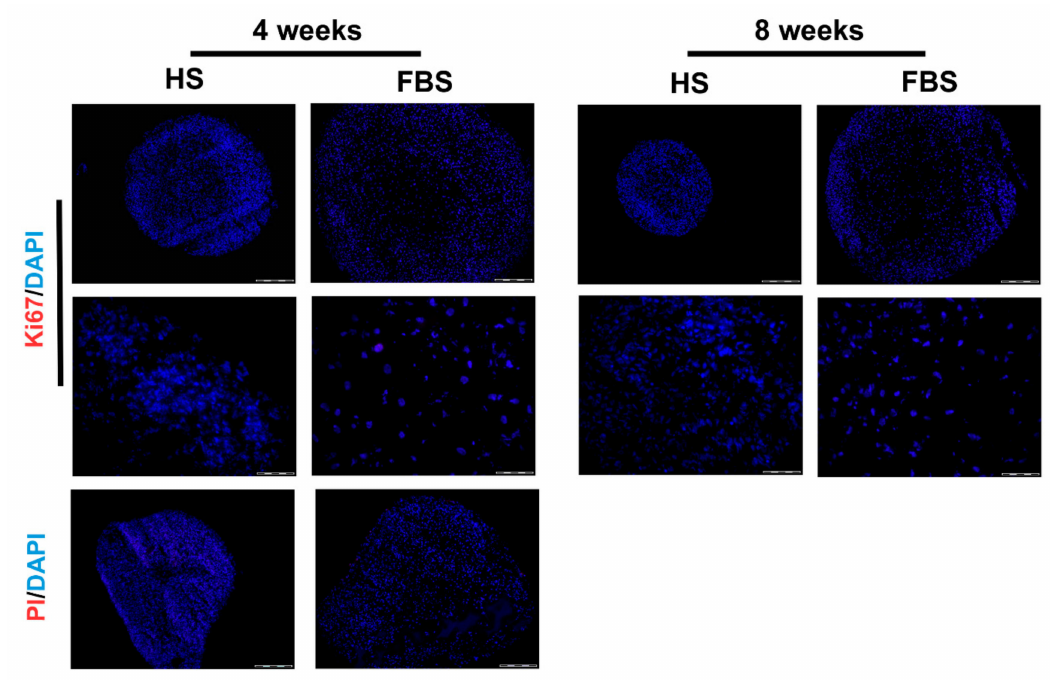
Figure 7. Analysis of cell proliferation and viability of microtissues from one representative donor cultivated for 4 weeks in the medium containing either HS or FBS. (Upper rows) Immunohistochemical analysis of the proliferation marker, Ki67. Red: Ki67. Blue: Cell nuclei. Scale bars upper row: 200 µ m. Scale bars lower row: 50 µ m. (Lower row) Viability staining using propidium iodide (PI). Red: Propidium iodide. Blue: Cell nuclei. Scale bars: 50 µ